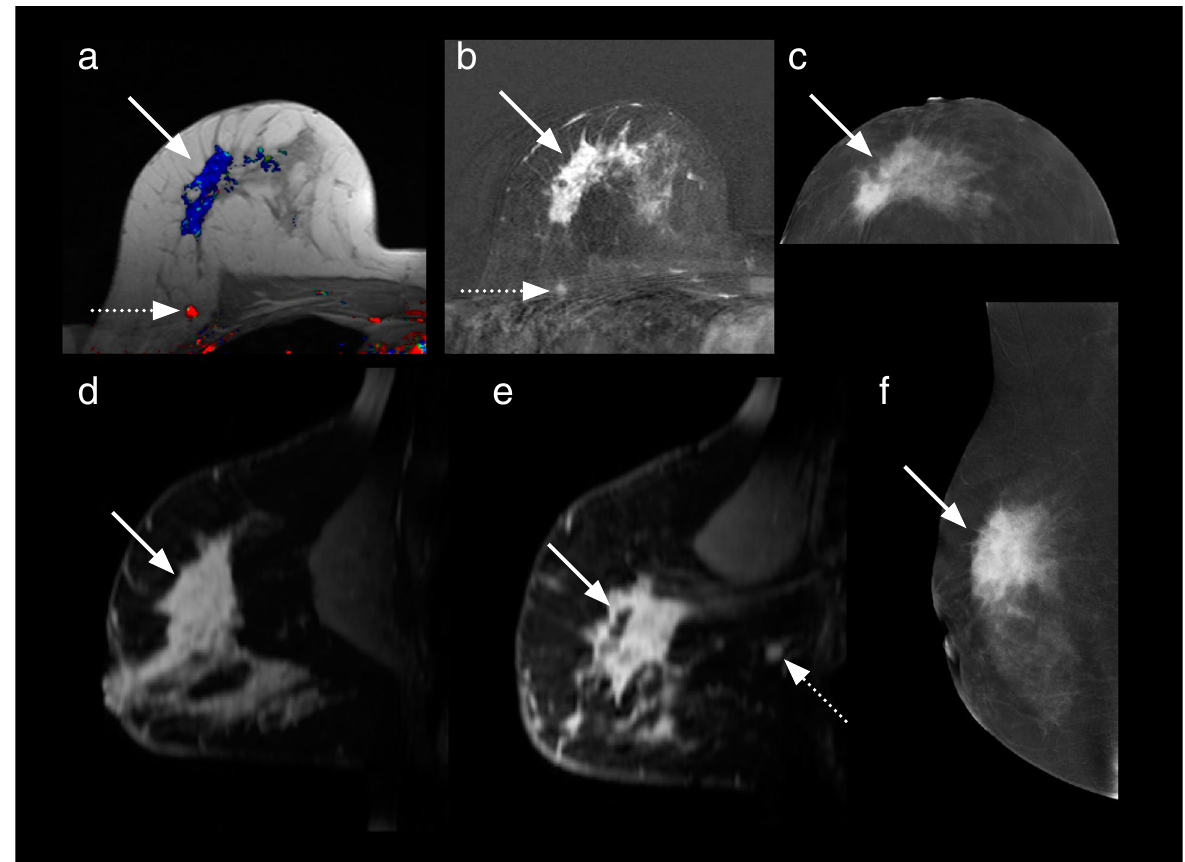
Fig. 7 Case number 5 of Table 3. 5. A 47-year-old patient with a palpable right breast mass. Images of the right breast: MRI ( a ) axial post-contrast T1-weighted non-fat suppressed image with colour overlay, ( b ) Fat suppressed axial post-contrast ( d, e ) sagittal post-contrast T1-weighted subtraction images. CEM ( c ) recombined CC view, orientated to match the axial MRI images ( f ) recombined MLO view. CEM and MRI both demonstrated the index lesion (solid arrows), a pleomorphic grade 3 invasive lobular carcinoma. MRI showed a moderately enhancing additional 6-mm mass in the postero-superior aspect of the right breast (dotted arrows). This lesion is out of the field of view on CEM. The additional